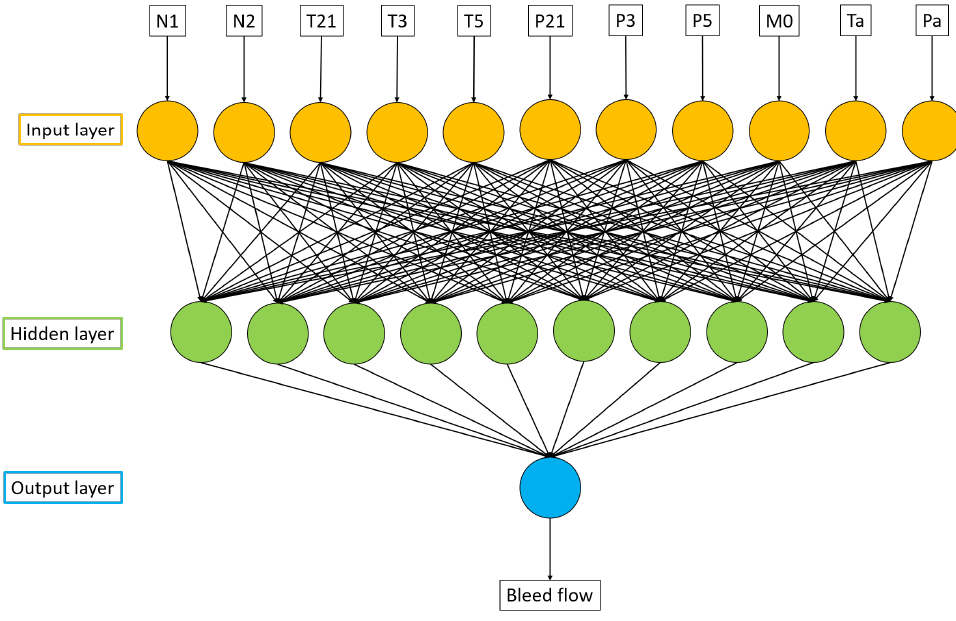
Figure 7. Neural network for estimating the bleed flow.